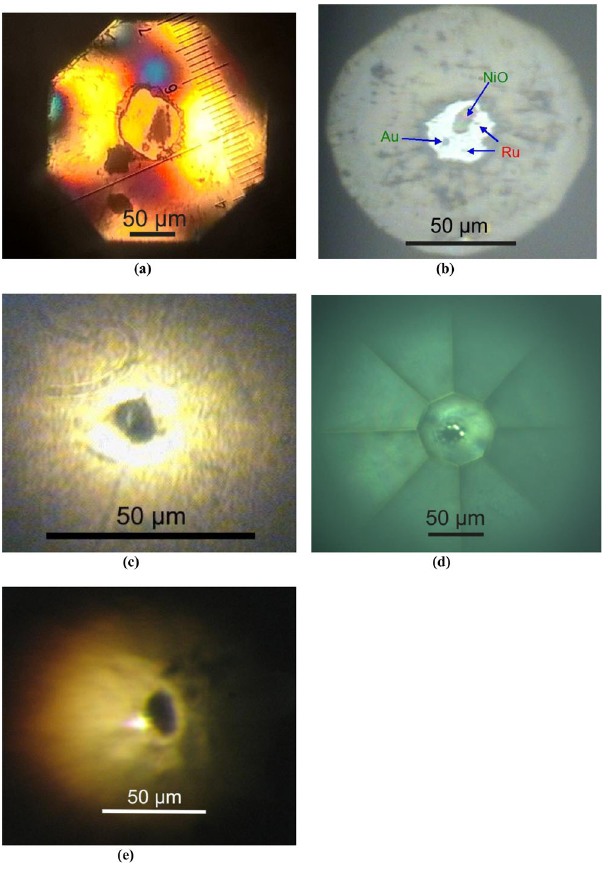
Fig. 1 The sample loading examples. a The mount of quasi-hydrostatic measurements in PES-5 pressure medium. The powdered NiO sample at P~10 GPa, and a piece of Au are placed inside the hole in the Re gasket. The pressure medium is silicon oil PES-5 (run1). b The mount of hydrostatic measurements in Ne pressure medium. The powdered NiO sample at P~36 GPa, piece of Au and two Ruby chips are placed inside the hole in the Re gasket. The pressure medium is neon (run2). c The mount of hydrostatic measurements in Ne pressure medium with a cBN gasket. The powdered NiO sample at P~ 110 GPa are placed inside the hole in the cBN gasket. The pressure medium is neon (run3). d The mount of quasi-hydrostatic measurements in NaCl pressure medium with Re gasket. The powdered NiO sample at P~ 208 GPa are placed inside the hole in the Re gasket. The pressure medium is NaCl (run4). e The image of the experimental mount of non-hydrostatic measurements. The powdered NiO sample at ~209 GPa completely fi lls the hole in the central part of the cBN gasket. At the edge of cullet a small piece of gold, which was used as a pressure sensor. The culet has oval shape with dimensions ~25 × 30 μ m decompression. It is important to note here, that the pressure during the spatial scan across the phase boundary was constant. Taking into account the small beam spot size (2 × 4 µm 2 ) we believe that the observed splitting of 012 re fl ection is caused by the coex- istence of two different phases and is not related to the pressure gradient. We clearly observe a decrease of the intensity of re fl ec- tions corresponding to the HP phase and consequent increase of LP re fl ections intensity when crossing the phase boundary (see Fig. 6). We show the V-P relation of NiO measured in nonhydrostatic experiment (run5) in Fig. 7. The unit cell volume decreases gra- dually with pressure increase. At ~210 – 220 GPa we observed a fi rst-order iso-structural transition, which was accompanied by the volume drop of about 2.7%. The difference between the observed pressure values of the structural and the IMT 8 phase transitions can